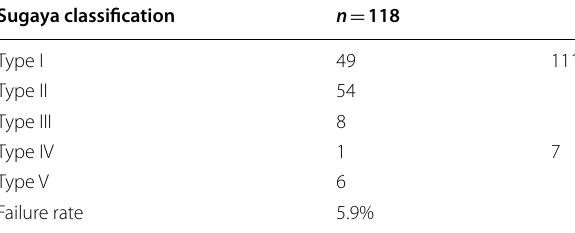
Table 3 Cuff integrity and failure rate Sugaya classification